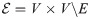
Example network to illustrate notation.G = (V, E) with n = 8 nodes, 10 links, V = {a, b, c, d, e, u, v, w}, and E = {(a, b), (a, w), (a, c), (b, u), (b, w), (u, e), (w, c), (w, d), (e, v), (d, v)}. We choose m = 1 link from the set E=V×V\E of all links not included in G. G′ is the network G after link (u, v) (represented as dashed line) was added: G′ ≔ G + uv. Then N(w) = {a, b, c, d}, dw=dw′=4, T(w) = T′(w) = 2 (the triangles abw and acw) and C(w)=2·24(4-1)=13. For u we obtain du = 2 and du′=3 and similarly T(u) = 0 and T′(u) = 1 (the triangle uev). N(u, v) = {e} and k = |N(u, v)| = 1. The clustering coefficient of G equals CG=18·(13+0+0+13+23+1+0+0)=18·73=724 and the clustering coefficient of the extended network is CG′=18·(13+13+13+13+23+1+0+1)=18·4=12.